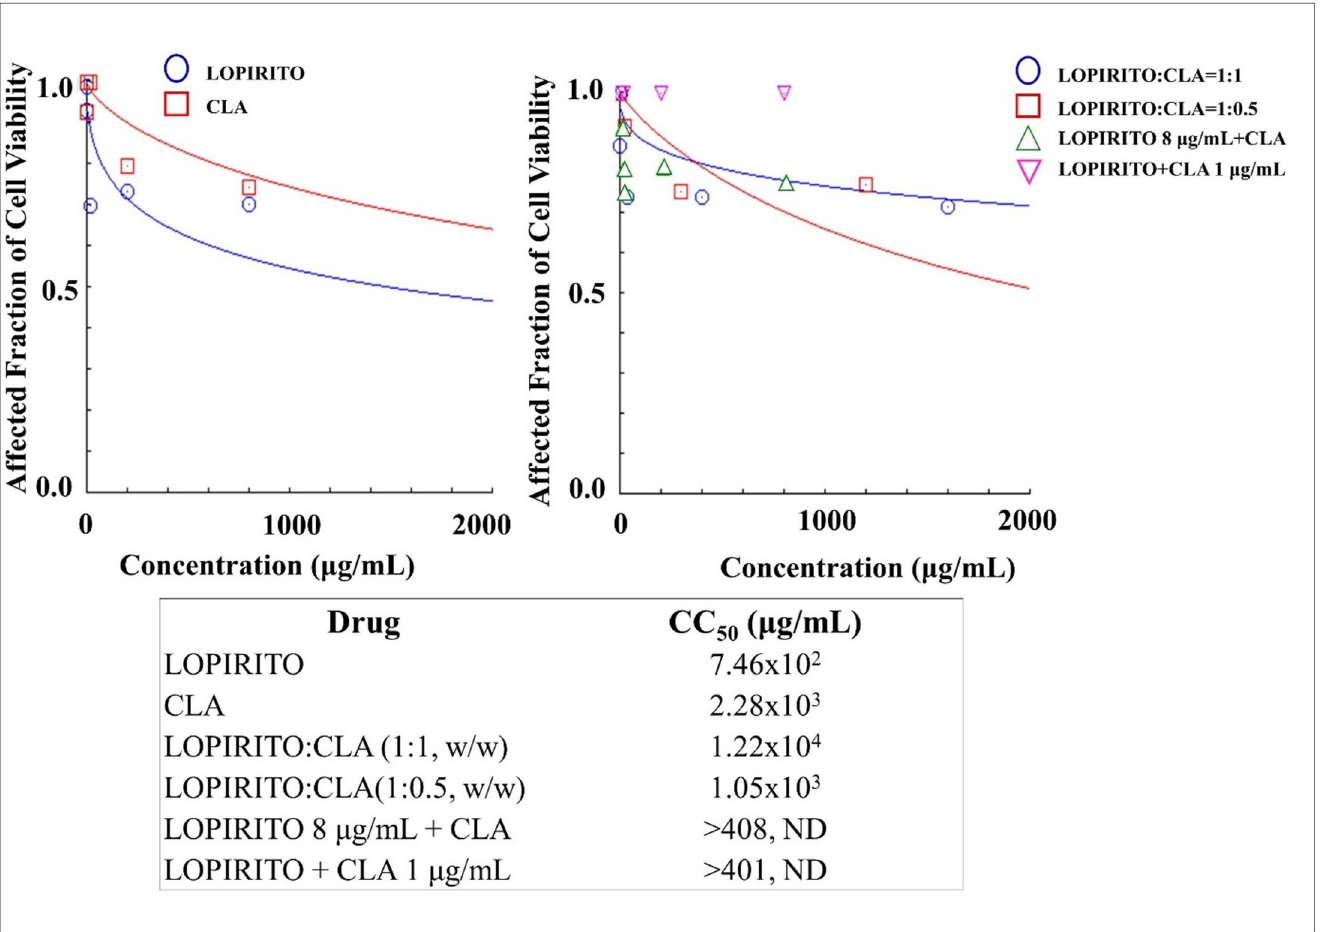
Fig 5. The cytotoxicities of Lopinavir-Ritonavir (LOPIRITO) and Clarithromycin (CLA) as a single drug (left) and dual drug combination in constant and non- constant ratios (right) analysed by using CompuSyn Software (n = 3). At non-constant ratios of LOPIRITO 8 μ g/mL + CLA, LOPIRITO was added at a concentration of 8 μ g/mL to each increased levels of CLA i.e. 0.2, 2, 10, 100, and 400 μ g/mL. On the other hand, CLA was then added at a concentration of 1 μ g/mL to each increased levels of LOPIRITO i.e. 0.2, 2, 10, 100, and 400 μ g/mL to produce LOPIRITO + CLA 1 μ g/mL.